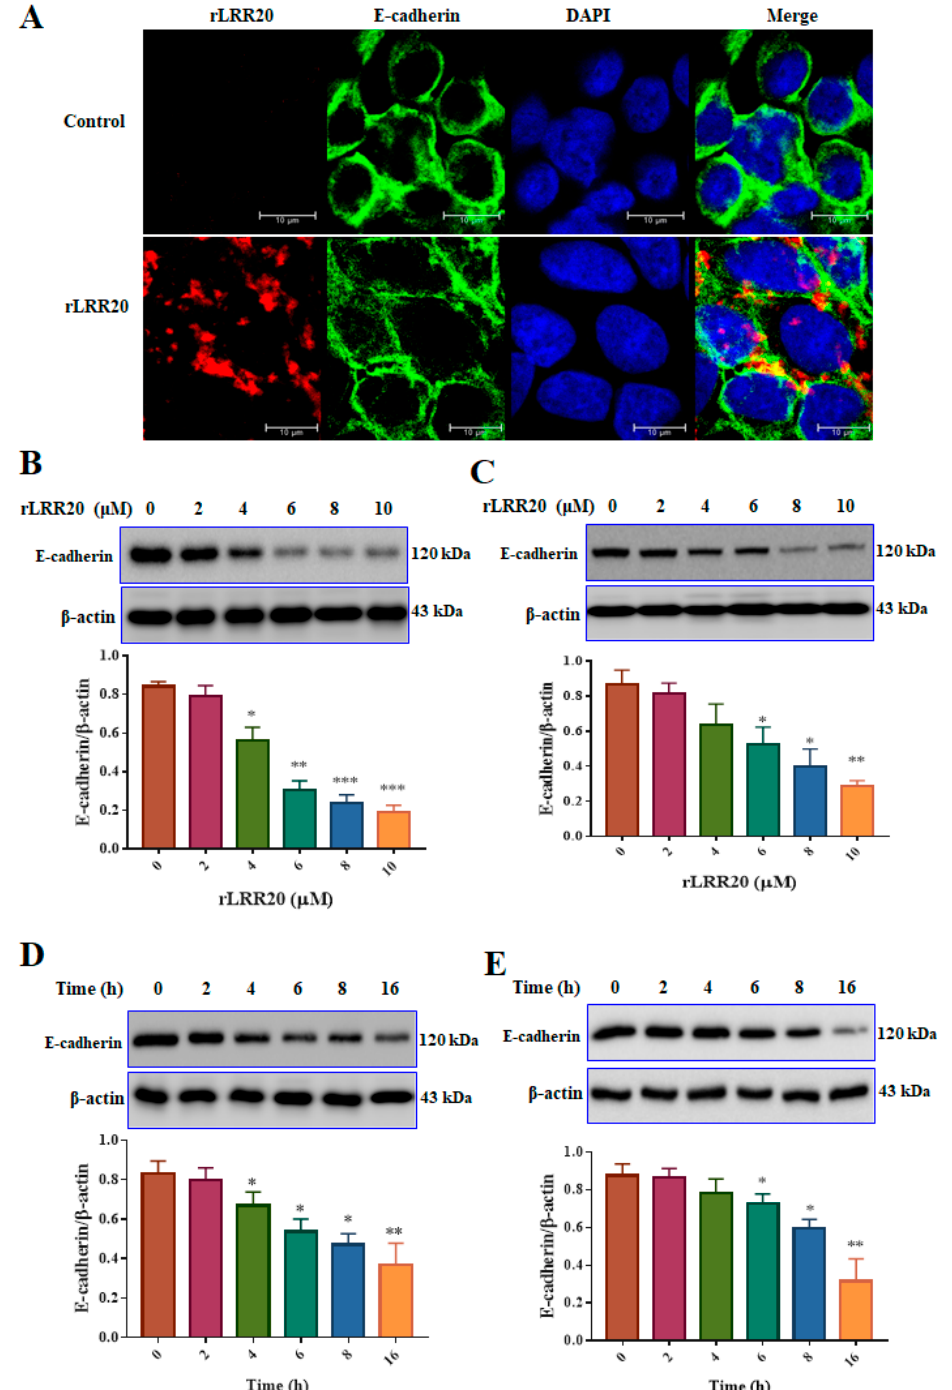
Figure 2. rLRR20 colocalized with E-cadherin on the cell surface and downregulated its expression. ( A ) rLRR20 colocalized with E-cadherin on the cell surface. Blue, nucleus; green, E-cadherin; red, rLRR20; yellow, colocalization of rLRR20 and E-cadherin. Effect of treatment with different doses (0, 2, 4, 6, 8, and 10 µ M) of rLRR20 for 8 h on the E-cadherin protein levels in HK2s ( B ) hRPTECs ( C ). Effect of treatment with 10 µ M rLRR20 for 0, 2, 4, 6, 8, or 16 h on the E-cadherin protein levels in HK2s ( D ) and hRPTECs ( E ). β -actin was used the internal control. *** p < 0.001; ** p < 0.01; * p < 0.05.